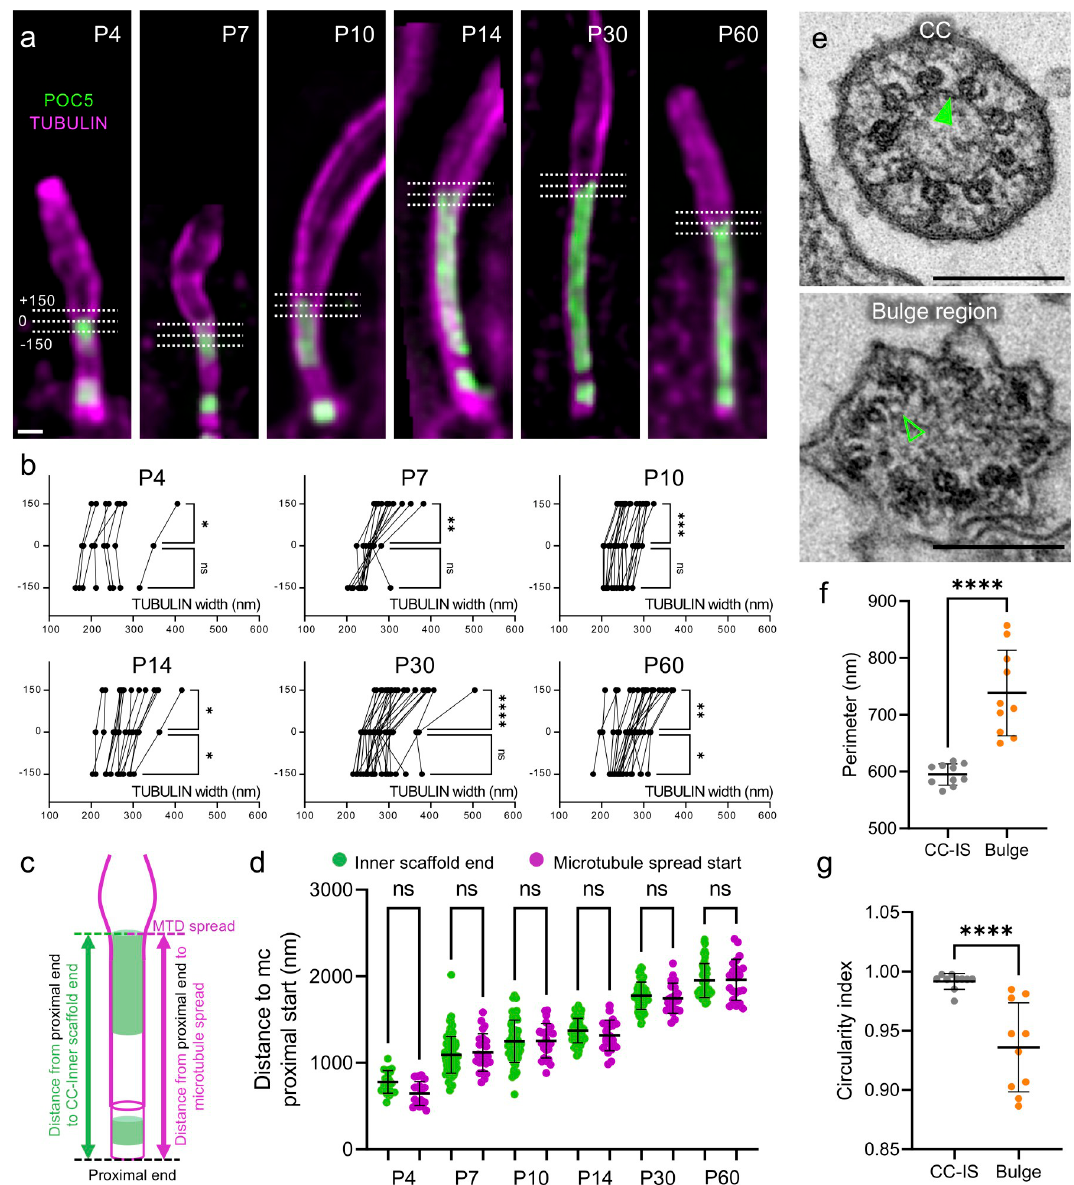
Fig 3. The CC inner scaffold acts as a structural zipper maintaining MTDs cohesion. ( a ) Expanded photoreceptors illustrating the measurements of tubulin width at 3 locations relative to the POC5 signal. 0: distal end of the CC inner scaffold; +150: 150 nm distally to the CC inner scaffold end; − 150: 150 nm proximally to the CC inner scaffold end. Scale bar: 200 nm. ( b ) Tubulin width measurements of the photoreceptor at the 3 locations depicted in (a) ( − 150 nm, 0 nm, +150 nm) from P4 to P60; � 3 animals per time point. ( c ) Scheme describing the measurements of the distances between mother centriole proximal end and CC inner scaffold signal end (green) or MTDs spread (magenta) used in (d). ( d ) Comparison of the position of the CC inner scaffold end (POC5) or microtubule spread start relative to the centriole’s proximal end, from P4 to P60; � 3 animals per time point. Note that inner scaffold measurements correspond to the POC5 data presented in Fig 2F. ( e ) EM transversal sections at the CC (top) or at the bulge region (bottom). Filled green arrowhead points to the CC inner scaffold; empty green arrowhead reveals the absence of the CC inner scaffold. Scale bar: 200 nm. ( f , g ) Distribution of the perimeter (f) or circularity (g) of the MTDs from transversal sections of photoreceptor CC (gray) or bulge (orange). N = 1 animal. Means and standard deviations are listed in S1 Table. The data underlying all the graphs shown in the figure are included in the S1 Data file. CC, connecting cilium; EM, electron microscopy; MTD, microtubule